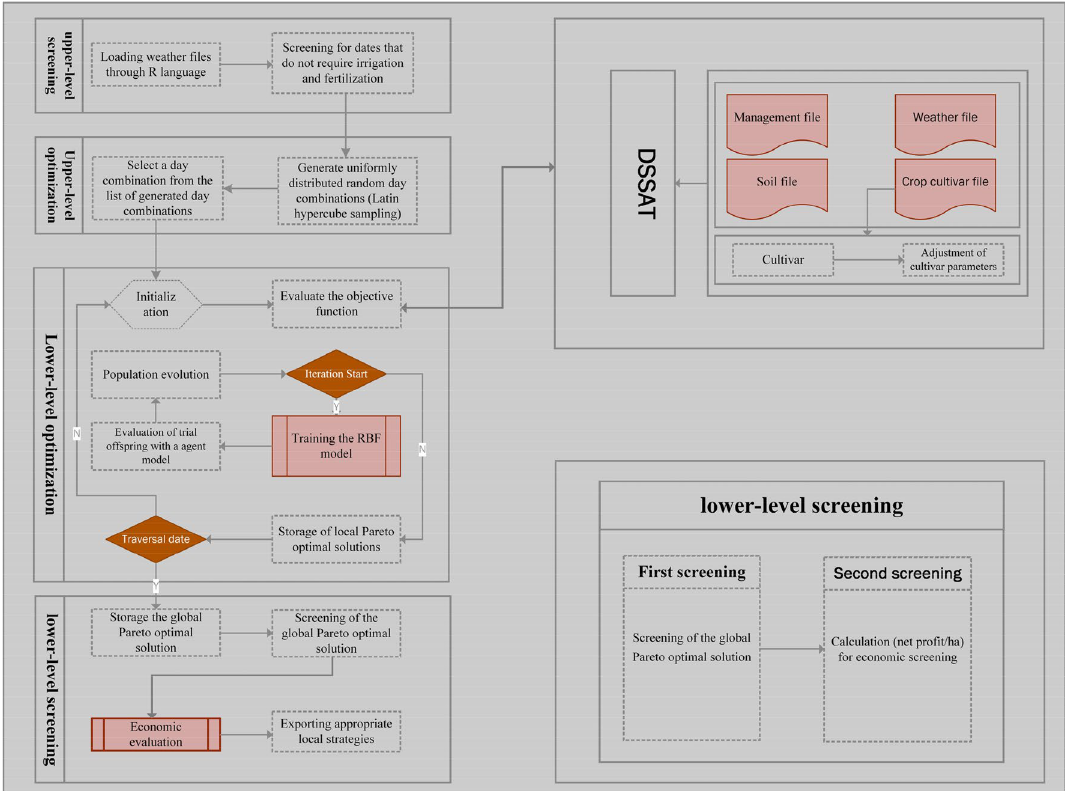
Figure 3. Proposed integrated bi-level screening, bi-level optimization and DSSAT